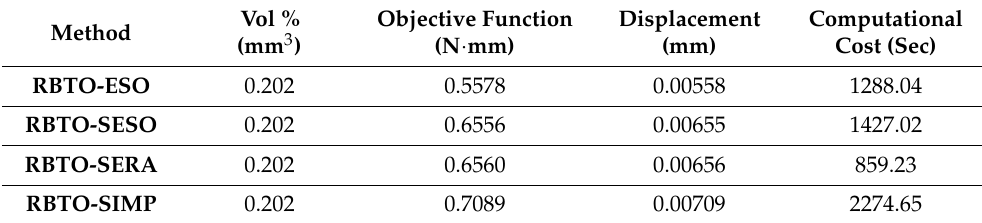
Table 2. Reliability-based topology optimization using evolutionary methods.